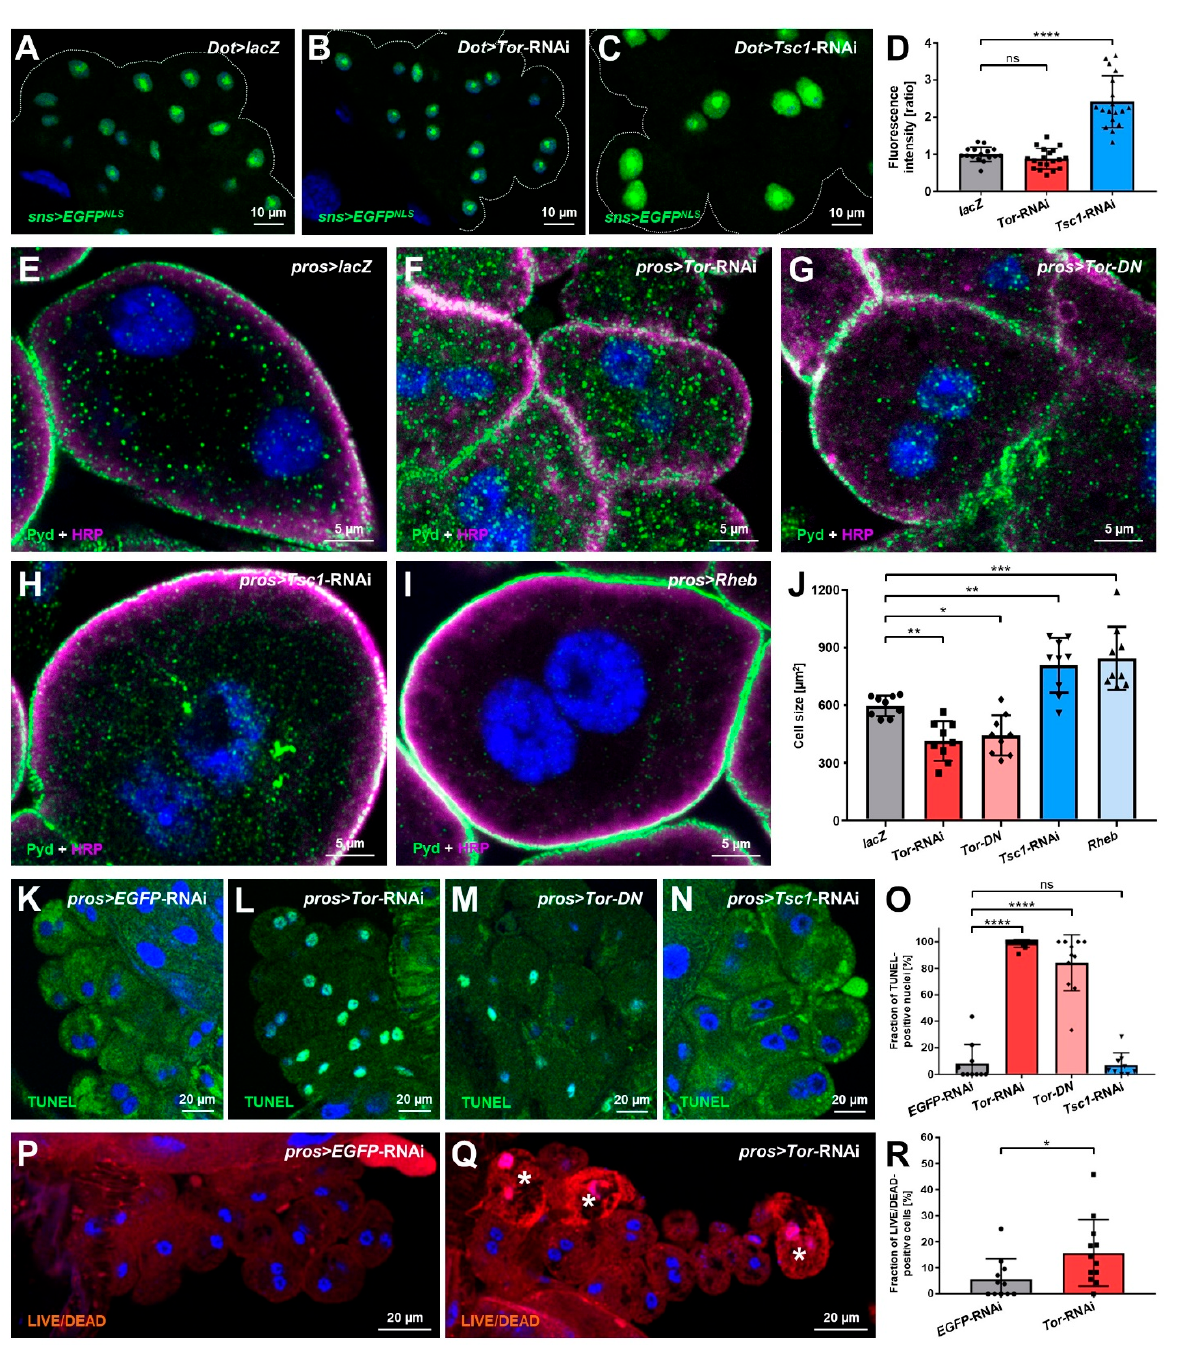
RNAi indicates basal autophagy in nephrocytes, and reporter fluorescence thus provides a convenient, quantifiable read-out for autophagy in these cells.